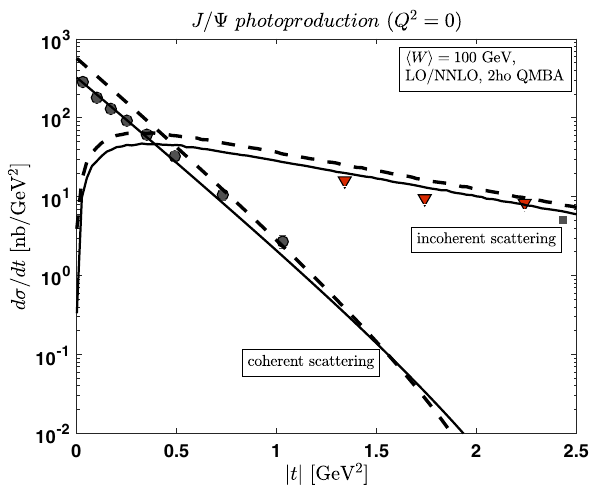
Fig. 8 Coherent and Incoherent photoproduction ( Q 2 = 0) cross sections within the kinematical conditions of the HERA experiments ( x IP ≈ 9 . 6 × 10 − 4 for (cid:4) W (cid:5) = 100 GeV). The dashed lines represent the QMBA-2ho predictions for the gluon distributions evolved at LO ; the continuous lines represent results with gluons at N NLO ( NLO and N NLO predictions cannot be distinguished in the Figure, as empha- sized in the text). The incoherent scattering calculations within QMBA- 2ho are made with B q = 0 . 7 GeV − 2 . Data as in Fig.